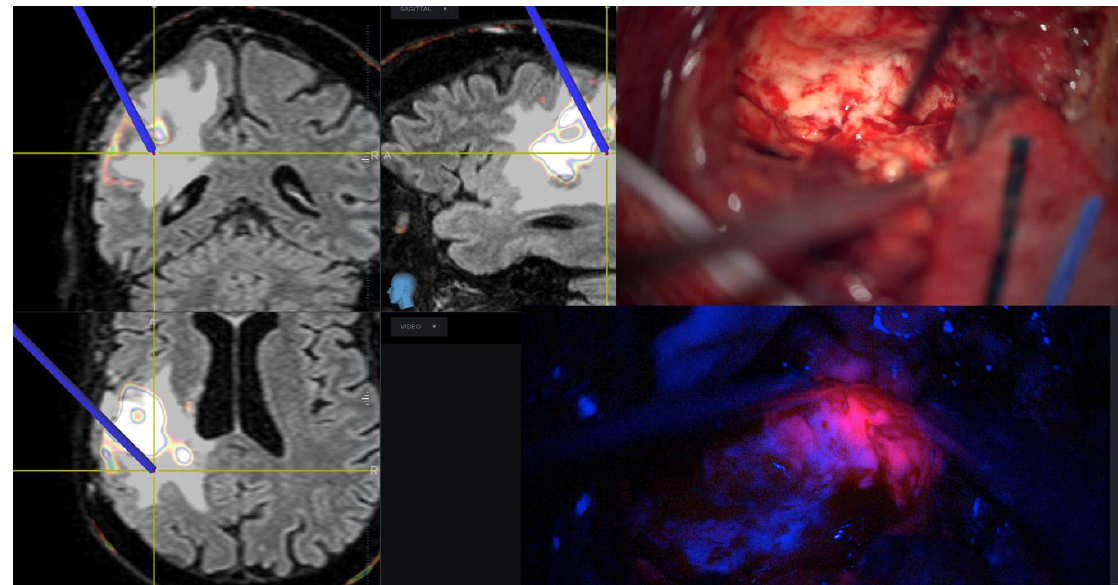
Figure 3. Images show an intraoperative view of peritumoral areas. In the neuronavigational view, the tracer is placed in the FLAIR hyperintensity zone beyond the enhancing nodule (EN). In the right upper image, there is the corresponding and apparently normal tissue under white light and in the image at the bottom the same surgical site under blue light revealing the presence of lava-like fluorescence.